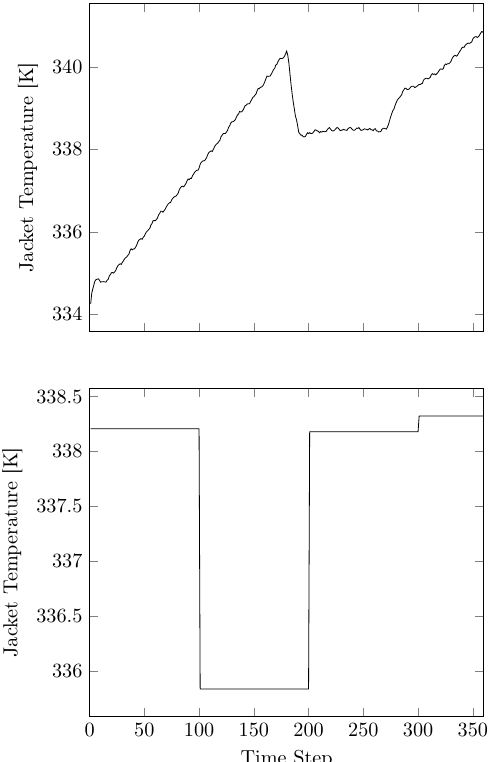
Figure 5. Comparison of input profiles between training ( top ) and newly generated ( bottom ) input profiles.